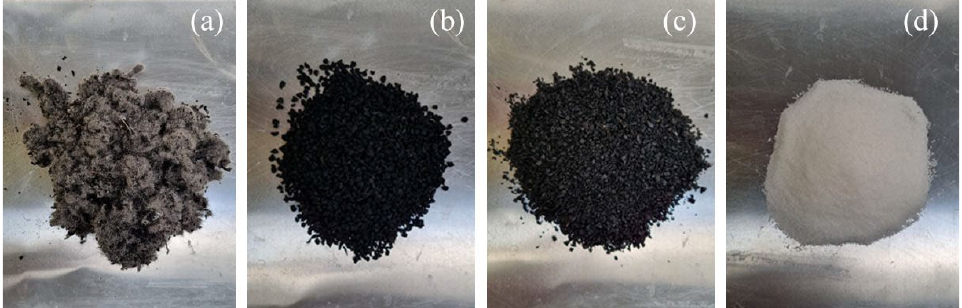
Figure 1. Additives used: ( a ) ELT textile fibre; ( b ) 4 mm ELT rubber; ( c ) 0.5–2.5 mm ELT rubber; ( d ) Sodium Polyacrylate.